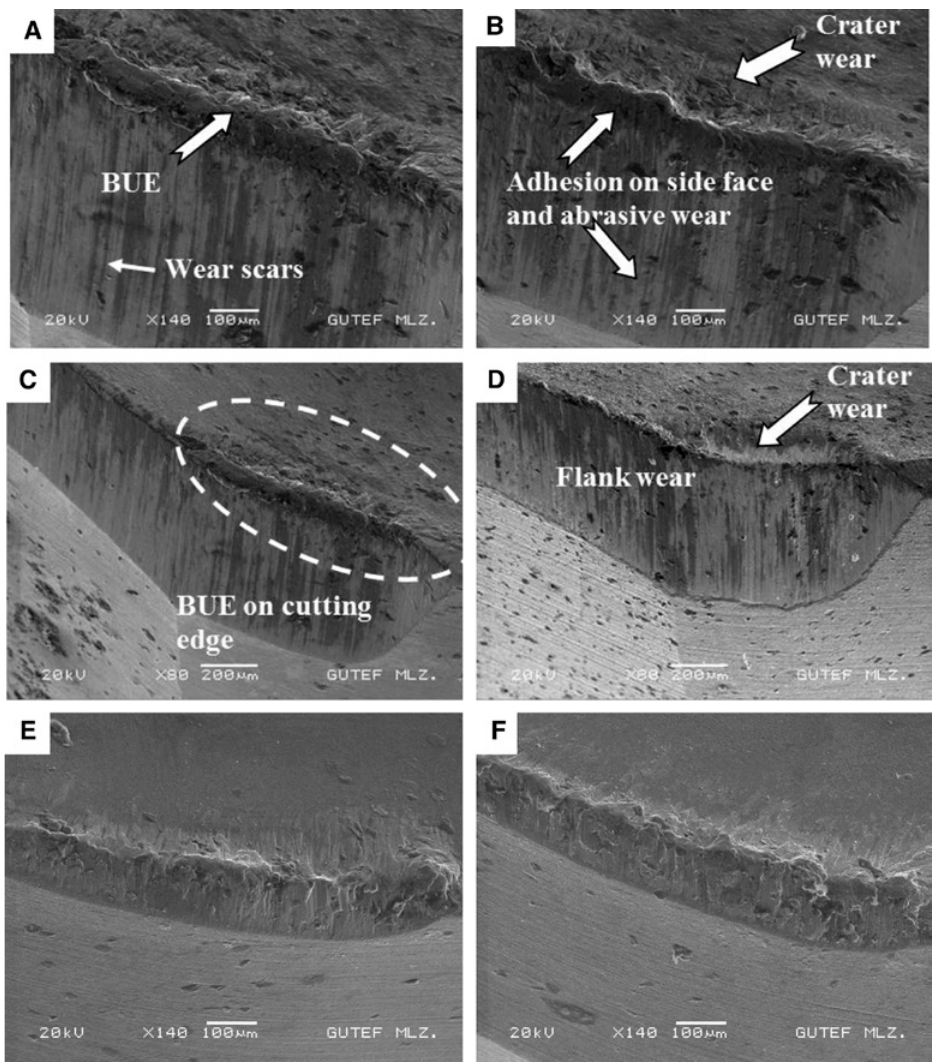
Figure 6: Tool wear occurred on different cutting tools with different cutting speeds: (A) uncoated-50 m/min, (B) uncoated-110 m/min, (C) coated-50 m/min, (D) coated-110 m/min, (E) CBN-50 m/min and (F) CBN-110 m/min.